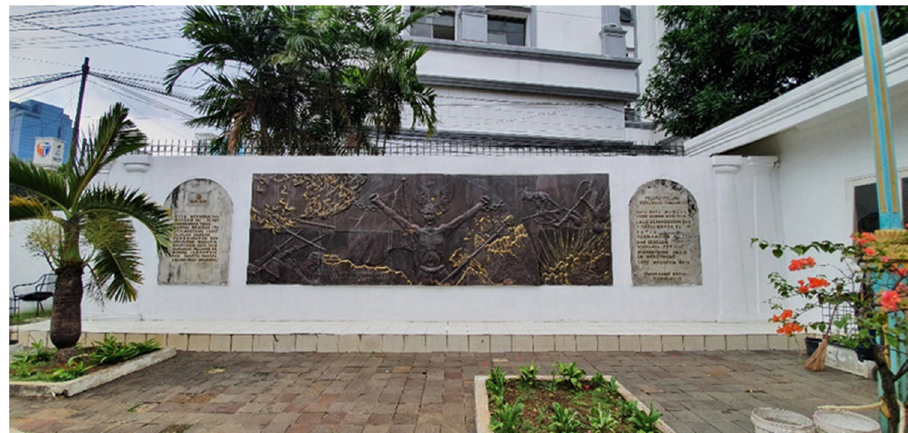
Figure 8: Wall panel in Gedung Juang Menteng , installed outside the building but hardly to be missed due to its large size and its